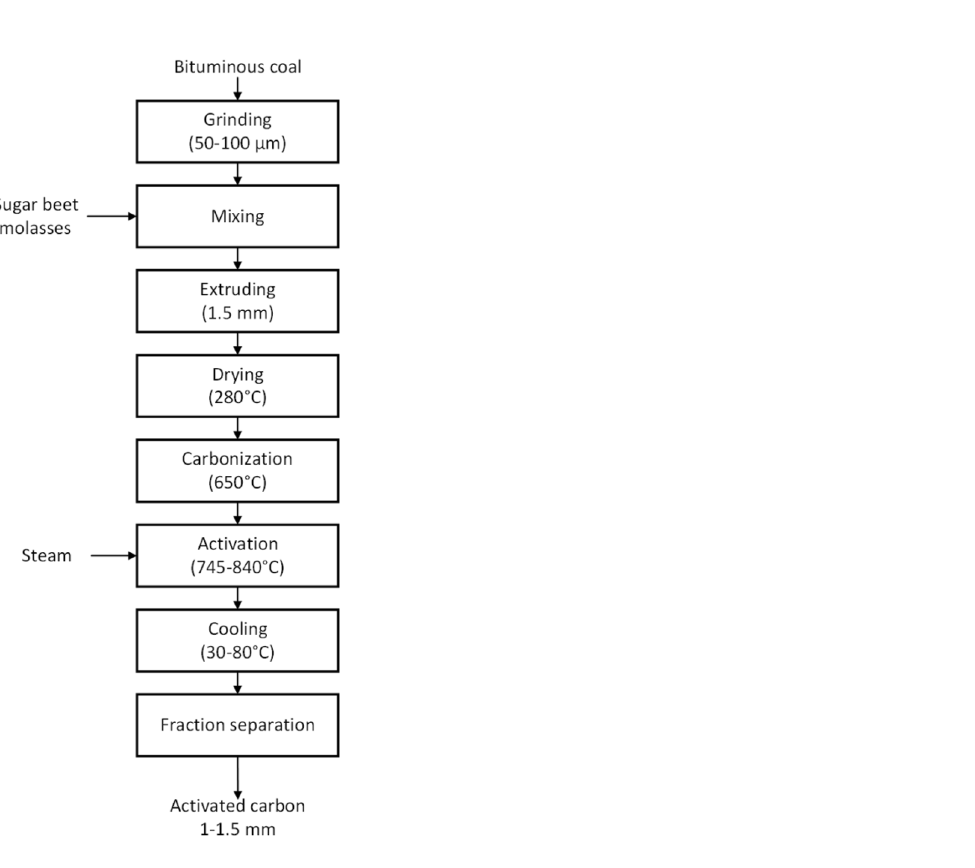
Figure 2. A scheme of preparation route used for obtaining activated